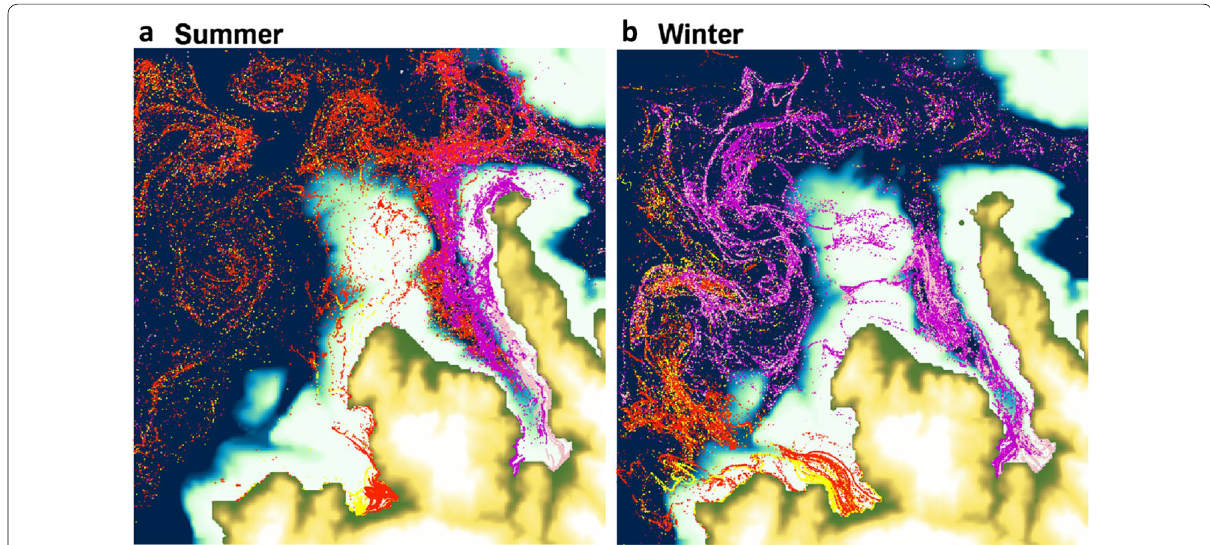
Fig. 3 Distributions of soil particle with a diameter of 3 μm in final states during a summer and b winter (0:00 UTC, June 30 and 0:00 UTC, Novem- ber 23 in 2014, respectively). Yellow , red , violet , and pink dots represent soil particles from the four rivers (Painta, Ubo, Ayanda, and Udara rivers,